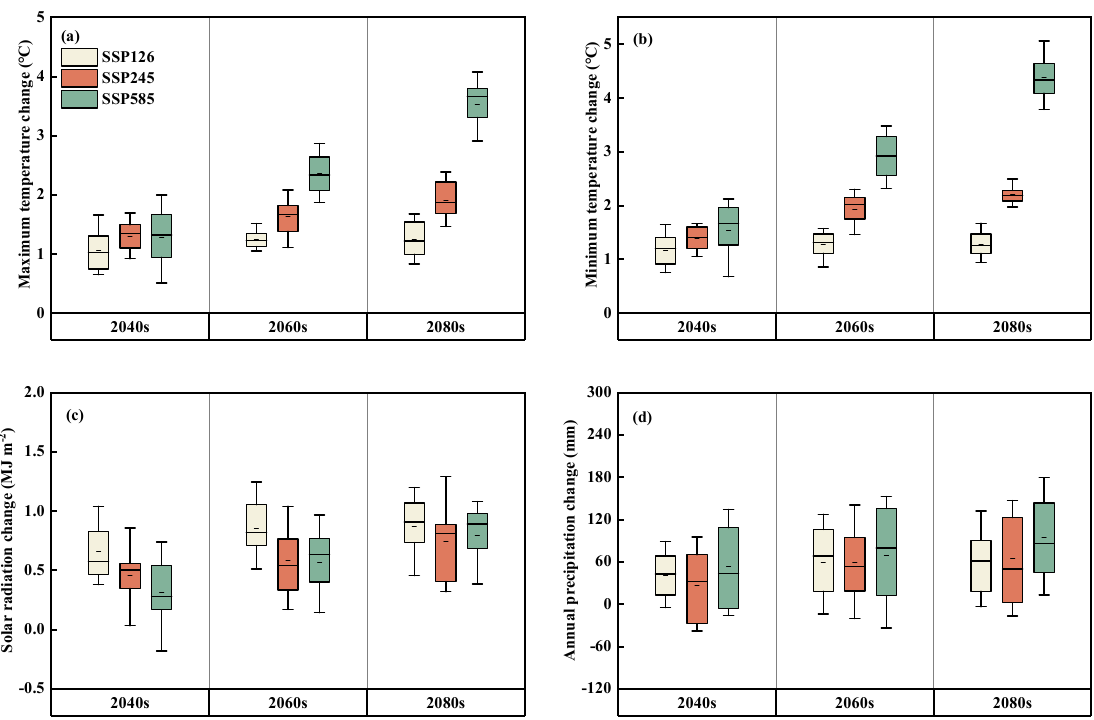
Figure 4. Projected changes in mean maximum and minimum temperature (°C), solar radiation (MJ m − 2 ), and annual precipitation (mm) during the rice growth period (April to September) for the 2040s, 2060s, and 2080s compared with 2000–2019 under the SSP126, SSP245, and SSP585 scenarios using six GCMs for the study station on the Songnen Plain of China. The box boundaries indicate the 25th and 75th percentiles; the black line and short line within the box mark the me- dian and mean, respectively; and whiskers below and above the box indicate the 10th and 90th percentiles,